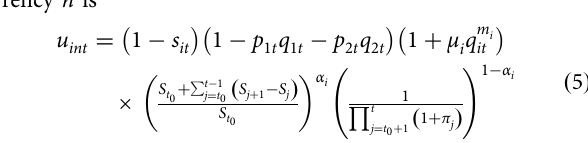
≤ 0 : 99. Player i ’ s process it ¼ p ¼ 0 : 5. Figure 3a i it 0